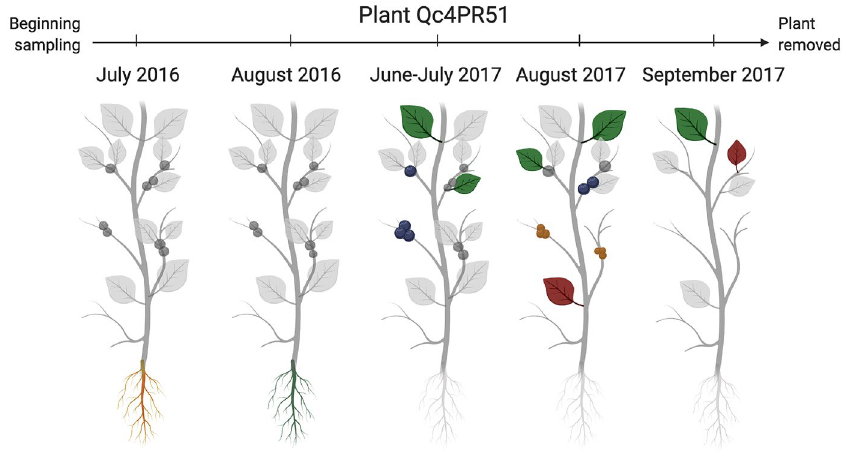
Figure 4. Outcome of tests on samples taken on a single highbush blueberry plant (Qc4PR5-1, cultivar Blueray,) in 2016 and 2017. Legend: red root (+); green root (−); red fruit (+); blue fruit (−); red leaf (+); green leaf (−). Gray tissues (roots, fruit, leaves) were not